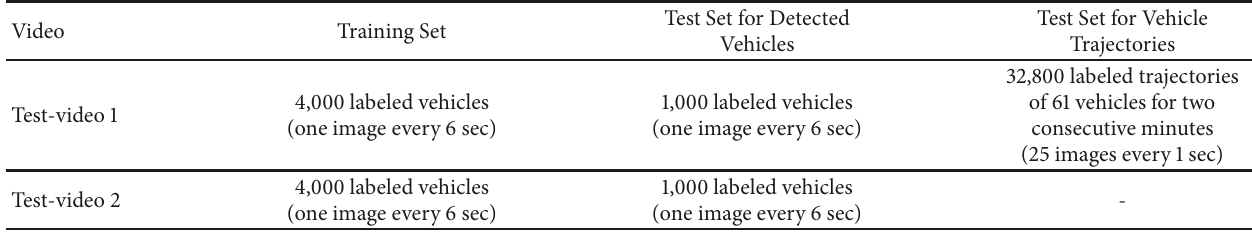
Table 2: Training and test sets for detection and